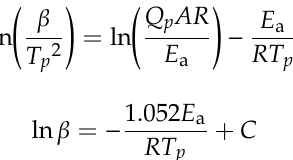
Figure 4. ZAA curing exothermic curve under different heating rate.